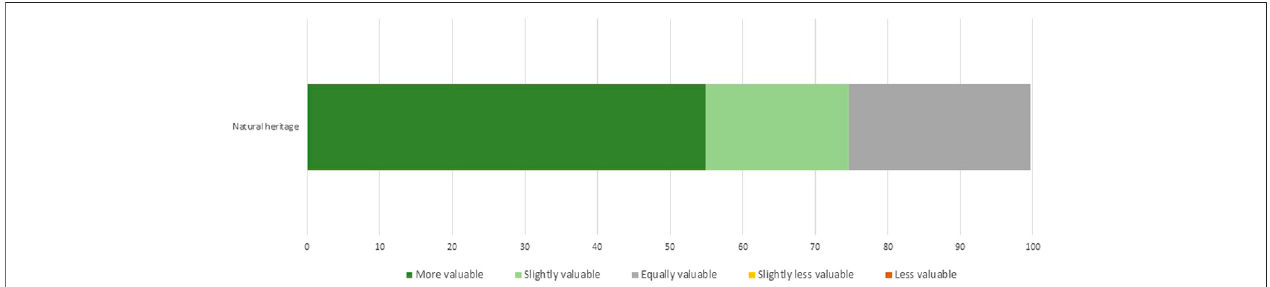
FIGURE 1 | Perception of natural heritage of La Puebla de la Sierra compared to other communities in the Man and Biosphere Reserve of La Sierra del Rincon.